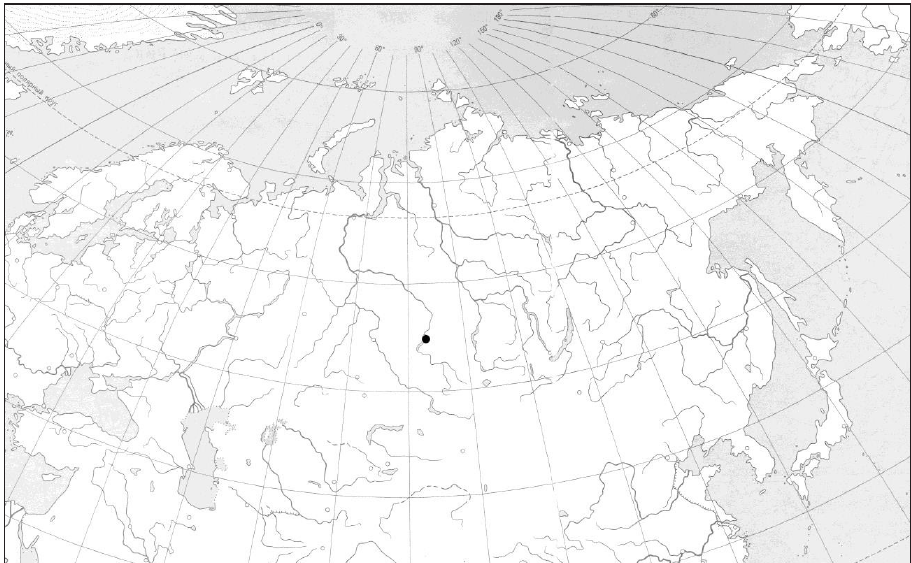
Figure 2. Position (black circle) of the studied area at the border of Novosibirsk city and Berdsk town (54°47'37"N; 83°04'34"E – 54°50'04"N; 83°04'40"E; DMS), Novosibirsk Province, Russia, on a sche- matic map of northern